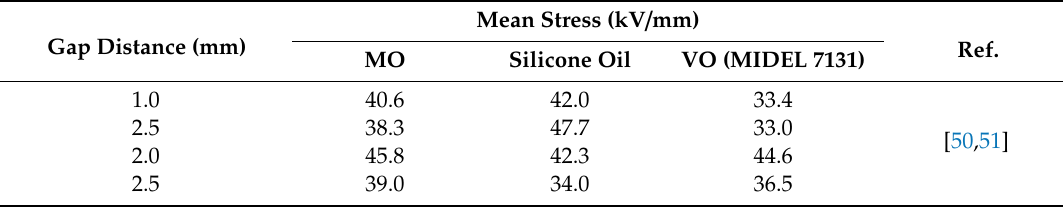
Table 5. Impulse BDV of various insulating fluids with spherical